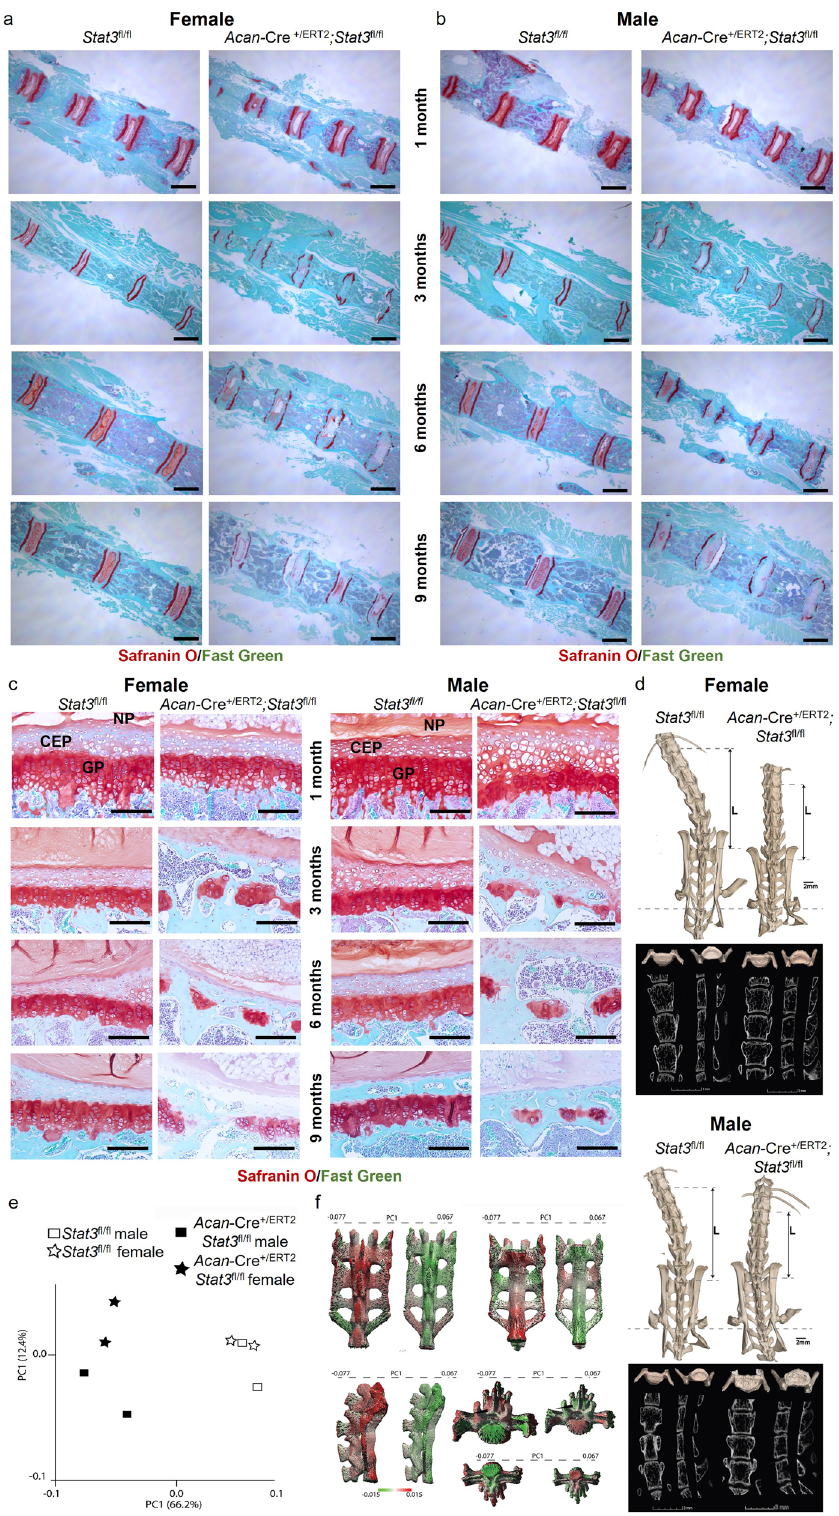
rates are in the low single digit range 32 ; cartilage expands via increases in cell volume and matrix production rather than cell division. Our in vitro data from human chondrocytes suggest STAT3 increases expression of ECM genes (Fig. 1a). Thus, we hypothesized Stat3 may function in articular cartilage main- tenance by supporting matrix protein production and stability. Analysis of articular cartilage in Acan - Cre + /ERT2 ;Stat3 fl / fl mice